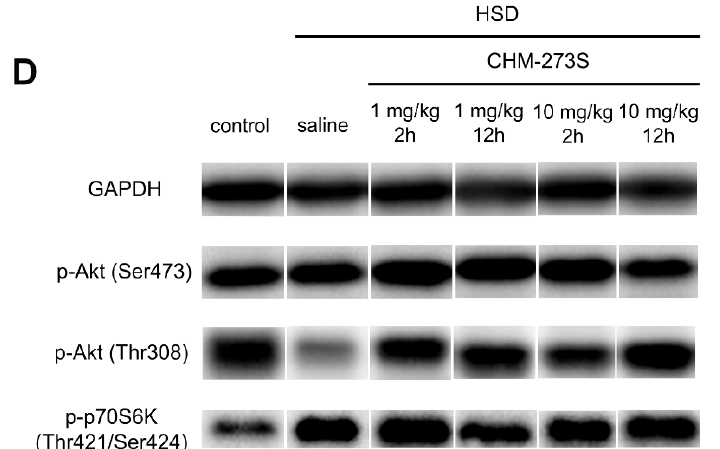
Figure 5. Western blot analysis of p-Akt (Ser473), p-Akt (Thr308), and p-p70S6K (Thr421/Ser424) proteins in the liver of high-sucrose diet (HSD)-fed, CHM-273-treated rats (2 or 12 h prior to sample collection), normalized to GAPDH. Three minutes before the liver sample collection, the animals received intravenous insulin infusion (10 U/kg). ( A ) p-Akt (Ser473) levels were not affected by the HSD, but treatment with CHM-273S (1 mg/kg intraperitoneal, i.p.) 2 or 12 h before sample collection ( n = 4 – 5) increased its expression in hepatocytes compared with the HSD-fed, saline-treated group ( n = 5; F (5,21) = 4.43, p = 0.006). ( B ) p-Akt (Thr308) was significantly reduced in HSD-fed, saline-treated rats, while CHM-273S given 2 or 12 h prior to collection at 1 or 10 mg/kg ( n = 4 – 5) restored its levels to the control values ( n = 4; F (5,21) = 2.96, p = 0.04). ( C ) p-p70S6K (Thr421/Ser424) levels did not differ among the treatment groups (F (5,21) = 1.09, p = 0.32). The results are presented as the mean ± standard error of the mean. * p < 0.05 versus the saline-treated group; one-way analysis of variance with the Holm –Šídák multiple comparisons test. ( D ) Representative Western blot bands for each group are shown; GAPDH serves as a loading control.